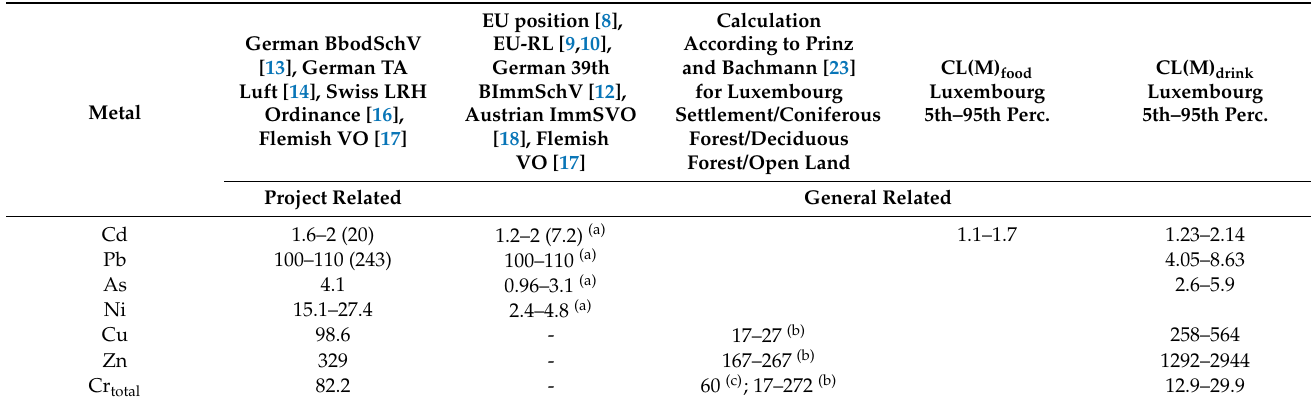
Table 20. Assessment values [ µ g m − 2 d − 1 ] for the protection of human health (in brackets: values for noncomparable exceptions and special